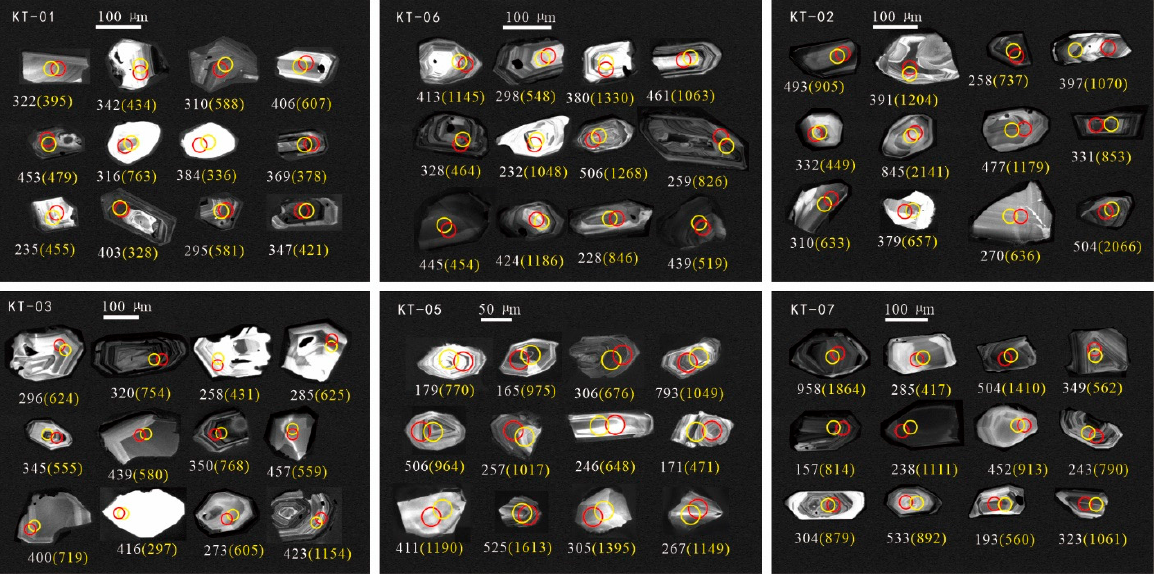
Figure 8. Plots of U-Pb ages versus Th/U ratio of detrital zircons. 4.3.1. Detrital Zircon U-Pb Ages Sample KT-01 from the Cangfg Formation: A total of 95 zircons were randomly tested, of which discordant ages of 6 zircons are not accepted because the concordance rate was less than 90%. The 206 Pb/ 238 U ages of 89 zircons range from 280 ± 2 Ma to 453 ± 3 Ma, (Table S1), and the main peak ages range from 300 Ma to 350 Ma (Figure 9).